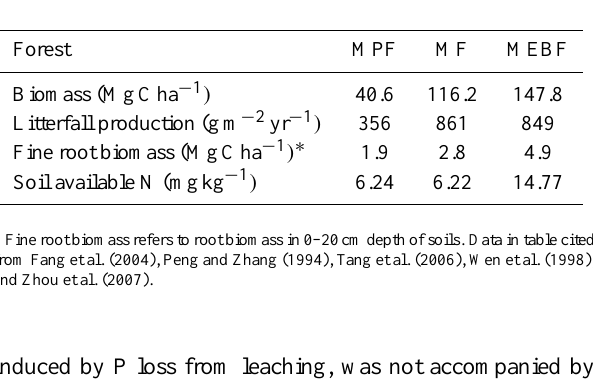
Table 5. Relevant factors related to soil acid phosphatase activity in three forests of Dinghushan Biosphere Reserve. MPF, Masson pine forest; MF, coniferous and broad-leaved mixed forest; MEBF, monsoon evergreen broad-leaved